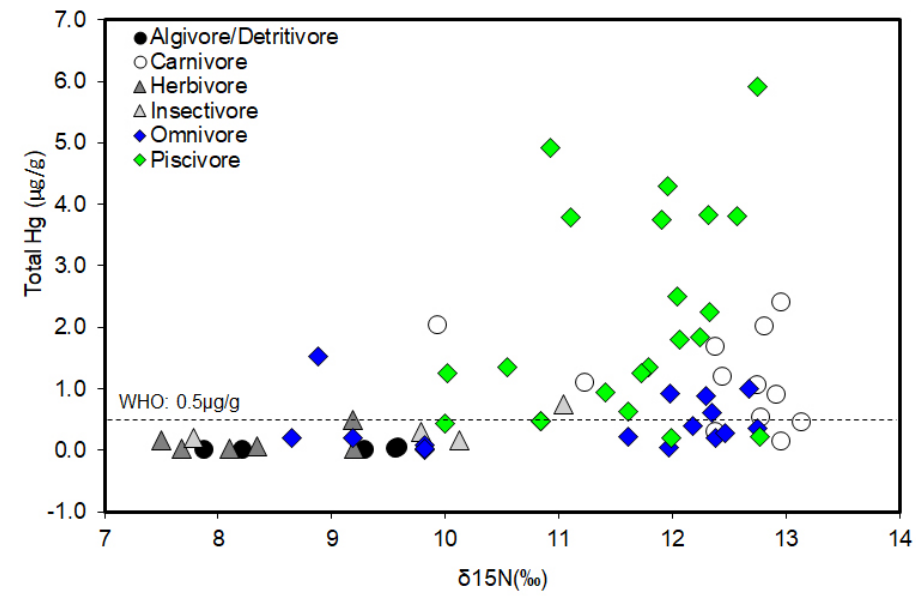
FIGURE 5 | Biomagnification of Hg in the Mazaruni River, Guyana, represented as the log total Hg concentrations plotted against nitrogen ( δ 15N) isotope ratios. Species were grouped together based on their trophic guild. Each symbol represents the average of all species within each trophic guild. The dashed horizontal line indicates the reference limit of 0.5 μg/g by WHO guideline for Hg in fish consumed by humans.